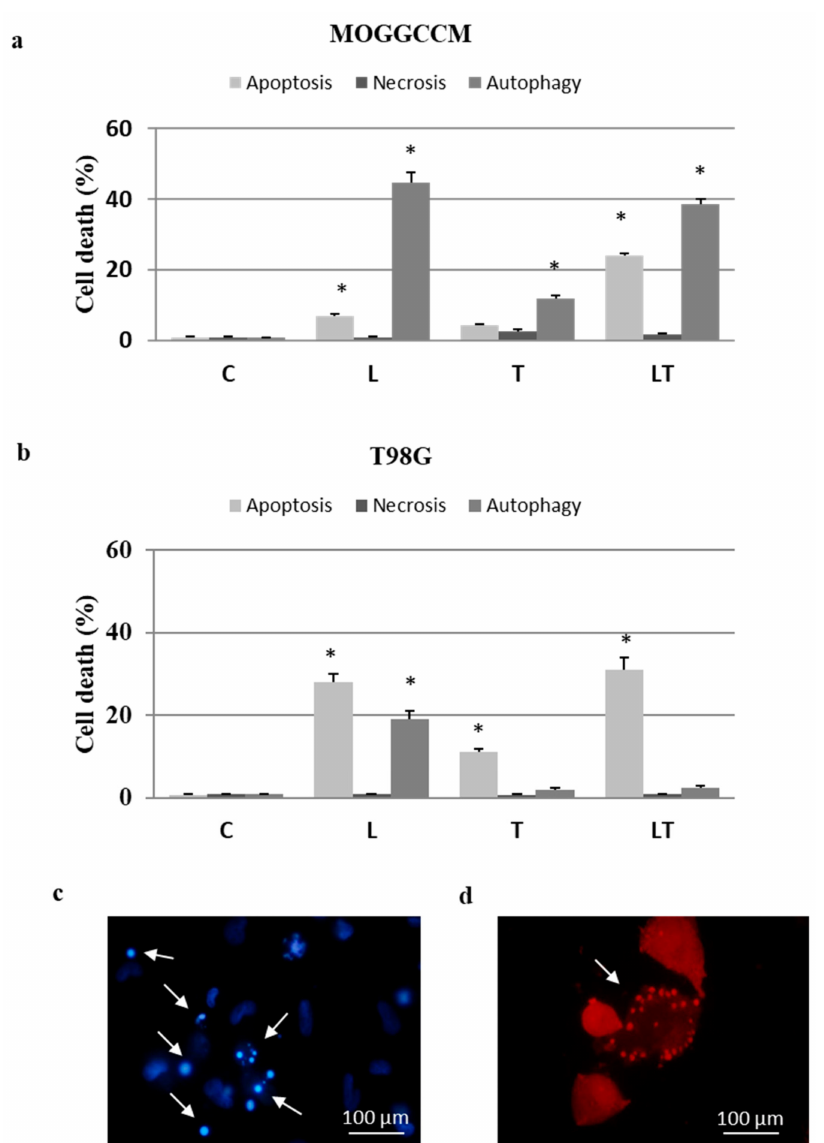
Figure 2. The effect of LY294002 (L) and temozolomide (T), applied alone and in combination (LT) on the levels of apoptosis, autophagy, and necrosis identified microscopically after staining with Hoechst 33342, acridine orange, and propidium iodide, respectively, in anaplastic astrocytoma (MOGGCCM; ( a )) and glioblastoma multiforme (T98G; ( b )) cells; ( c ) representative picture of apoptotic T98G cells (indicated by arrows) stained with Hoechst 33342 after LT treatment; ( d ) representative picture of autophagic MOGGCCM cells (indicated by arrow) stained with acridine orange after LT treatment. C—control, * p < 0.01 compared to